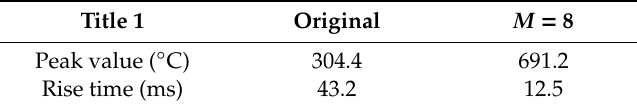
Table 2. σ = 0.0001 and m = 8; the peak value and rise time of butt-welded thermocouple after regularization.